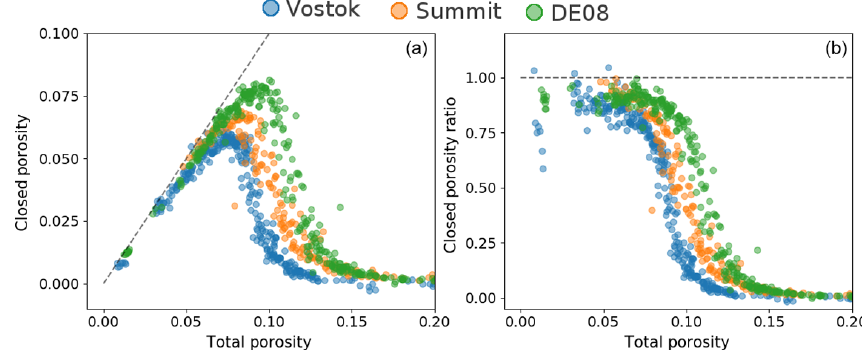
Figure 3. Same as Fig. 2, with the new α correction.